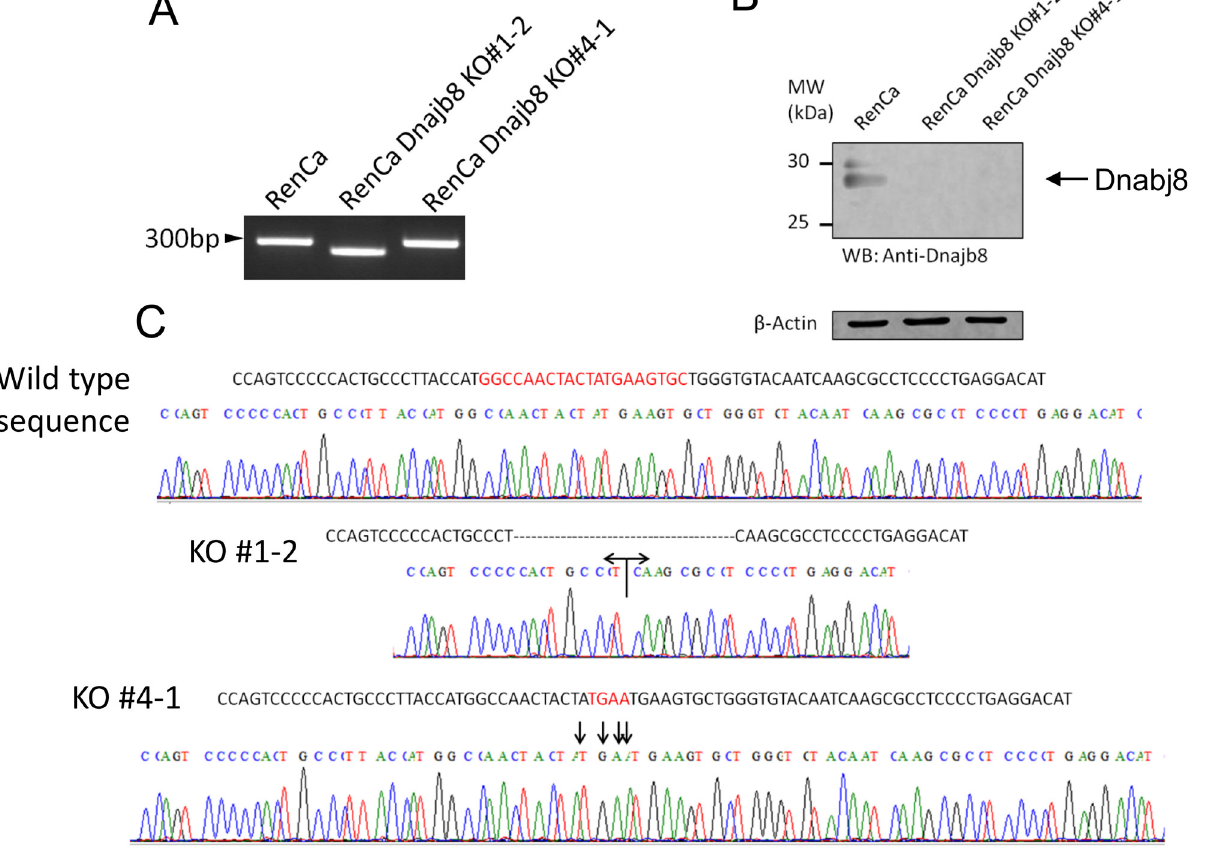
Fig 2. Establishment of Dnajb8 KO cells. (A) Amplification of the Dnajb8 region targeted by CRISPR/Cas9. (B) Western blot analysis of DNAJB8 protein. (C) DNA sequence of Dnajb8 KO cells.